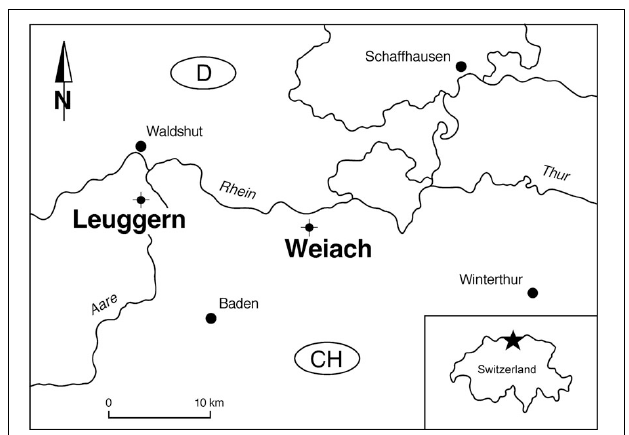
FIGURE 1 | Location of the Weiach and Leuggern core